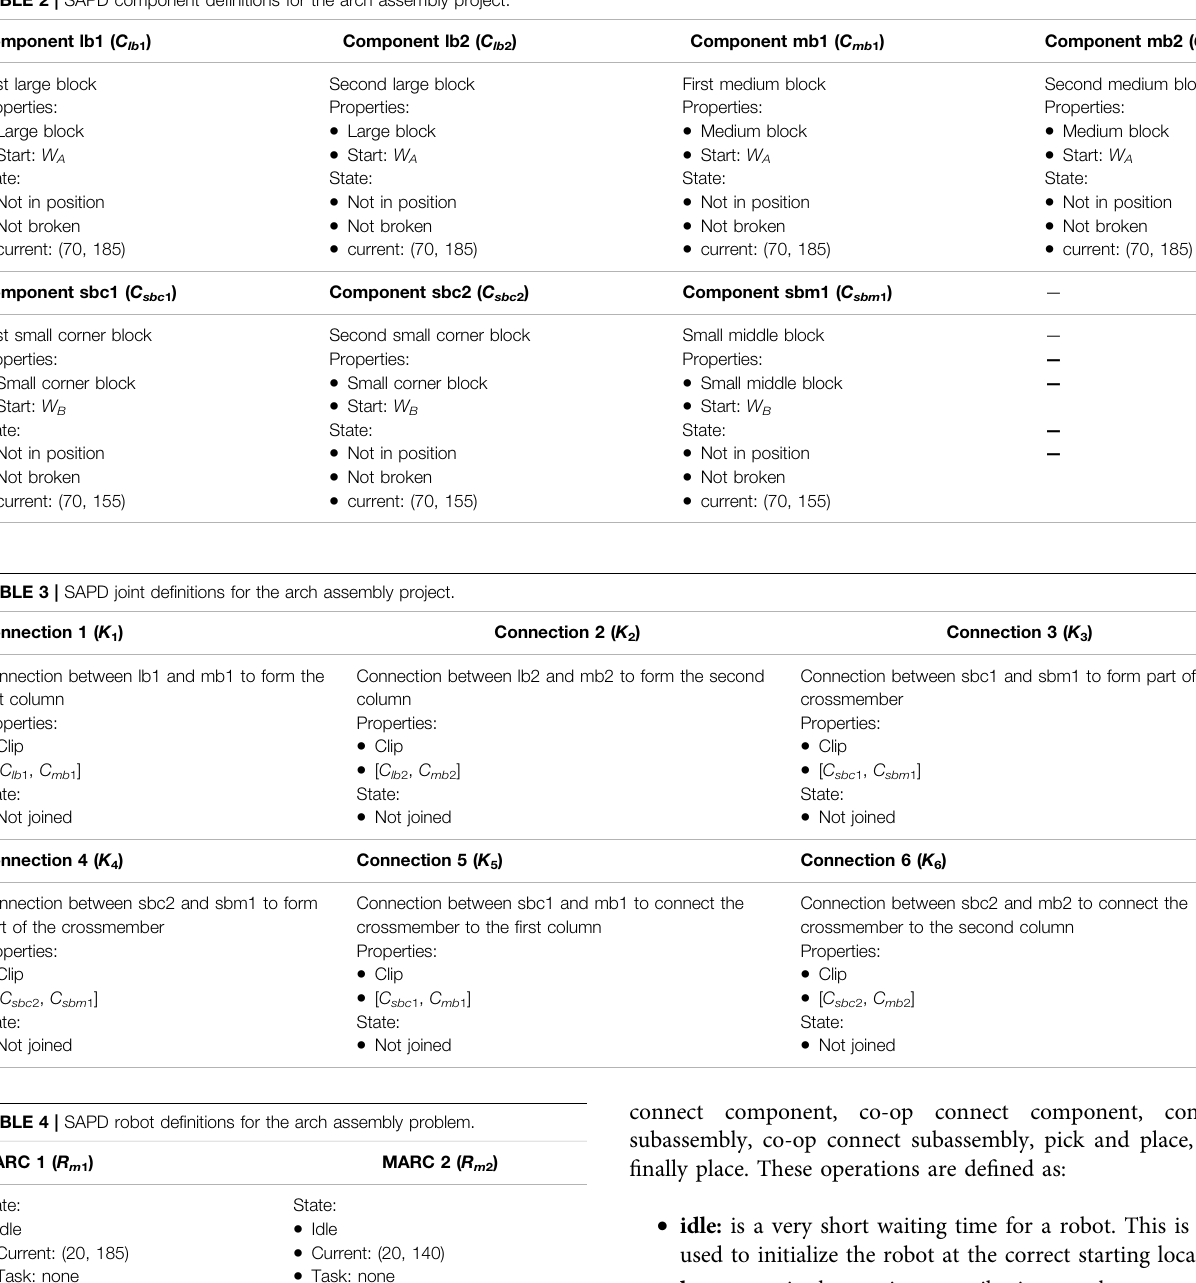
TABLE 2 | SAPD component de fi nitions for the arch assembly project.